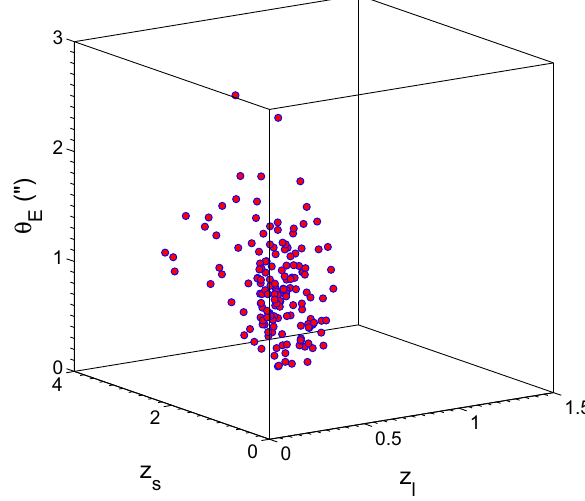
Fig. 1 Scatterplotofthecurrentsampleof158stronglensingsystems. One can see a fair coverage of redshifts in the combined